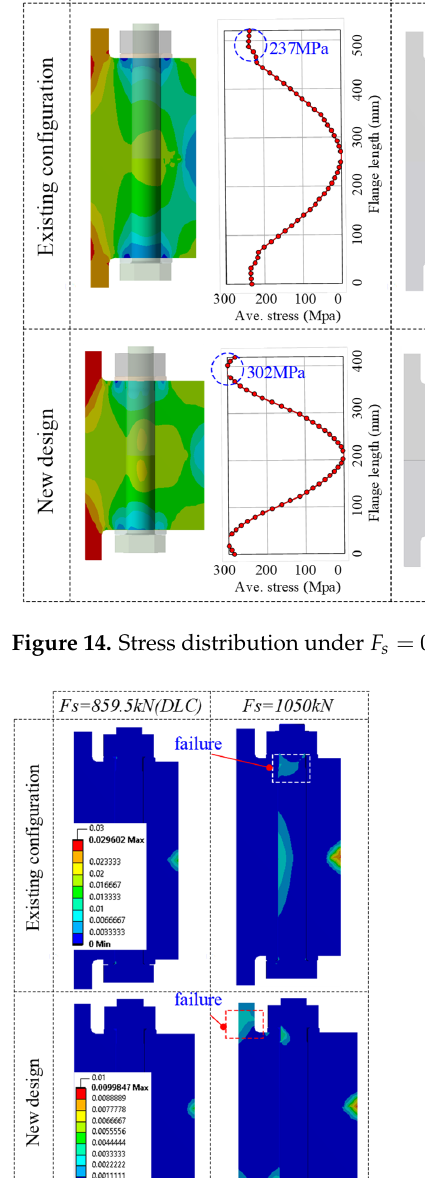
Figure 15. Failure of flange joint.